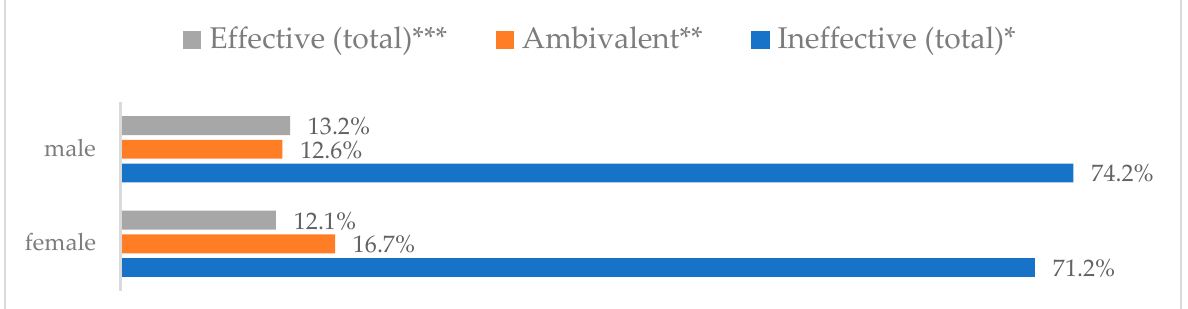
Figure 26. Taking preparations with inosine to prevent influenza virus infection by gender ( N = 905).